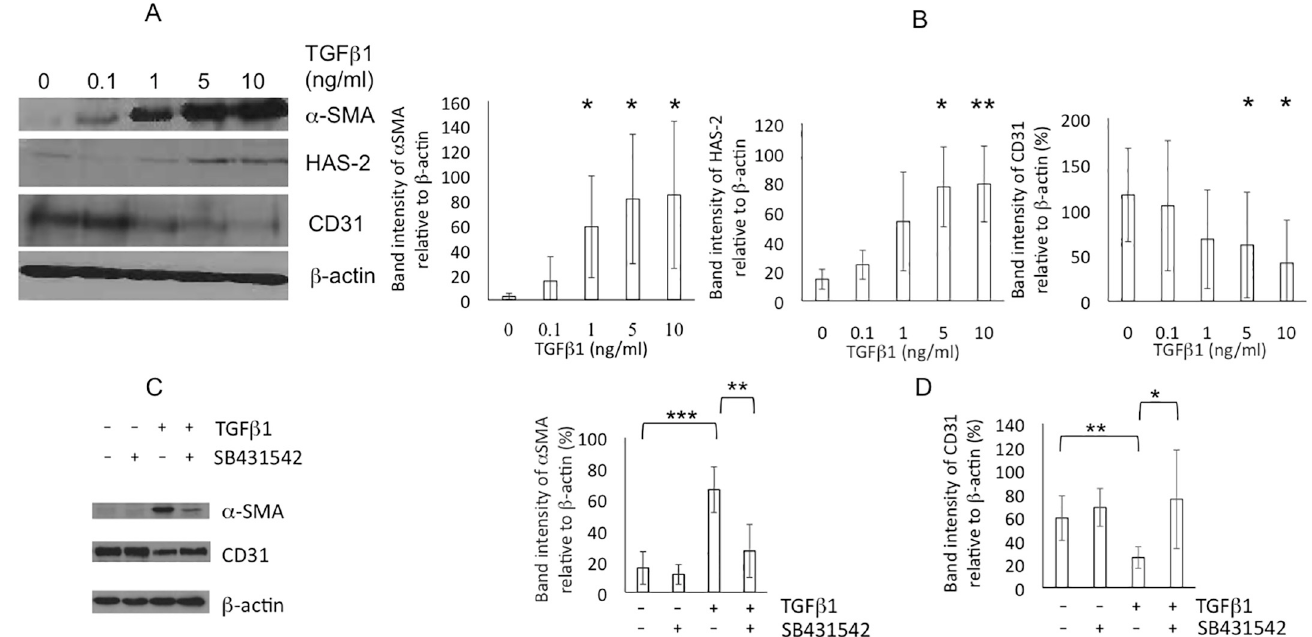
Fig 1. Normal valve endothelial cells (VEC). (A) Representative protein-immunoblot of normal VECs treated with 0, 0.1, 1, 5 and 10ng/ml TGF β 1 for 5 days (n = 4) illustrating expression of α SMA, HAS-2 and CD31. (B) Quantified expression of α SMA in (A) relative to β -actin. (C) Representative protein immunoblot illustrating effects of SB431542 on α SMA and CD31 expression. (D) Quantified expression of α SMA in (C) relative to β -actin. Statistical analysis was performed with Student’s t-test. � , �� , ��� P < 0.05, 0.01, 0.001 respectively.